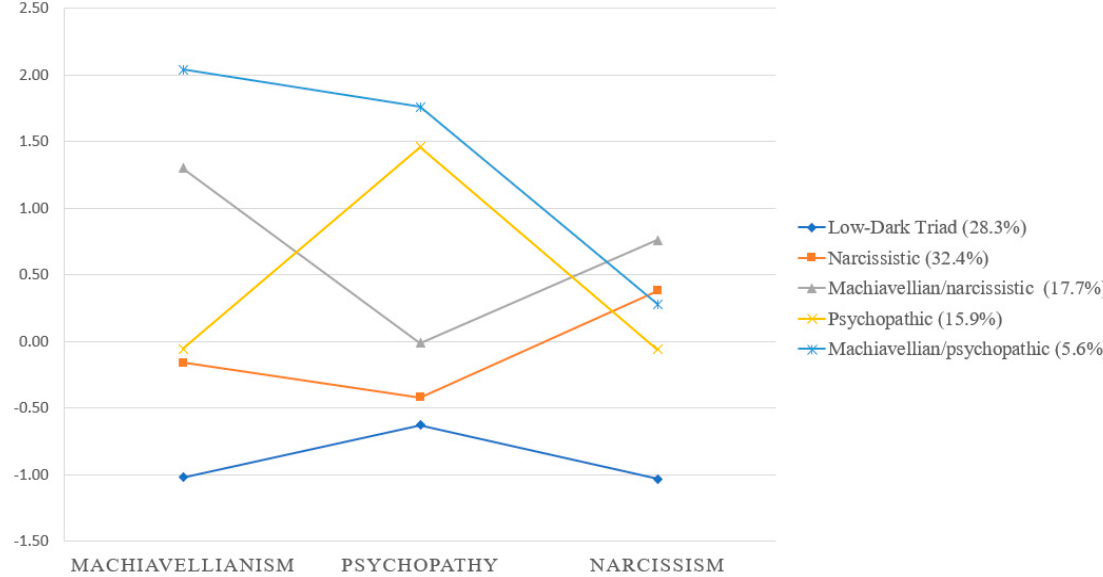
Figure 1. Mean Z-scores for the five-class solutions including the Dark Triad traits as class indicators.